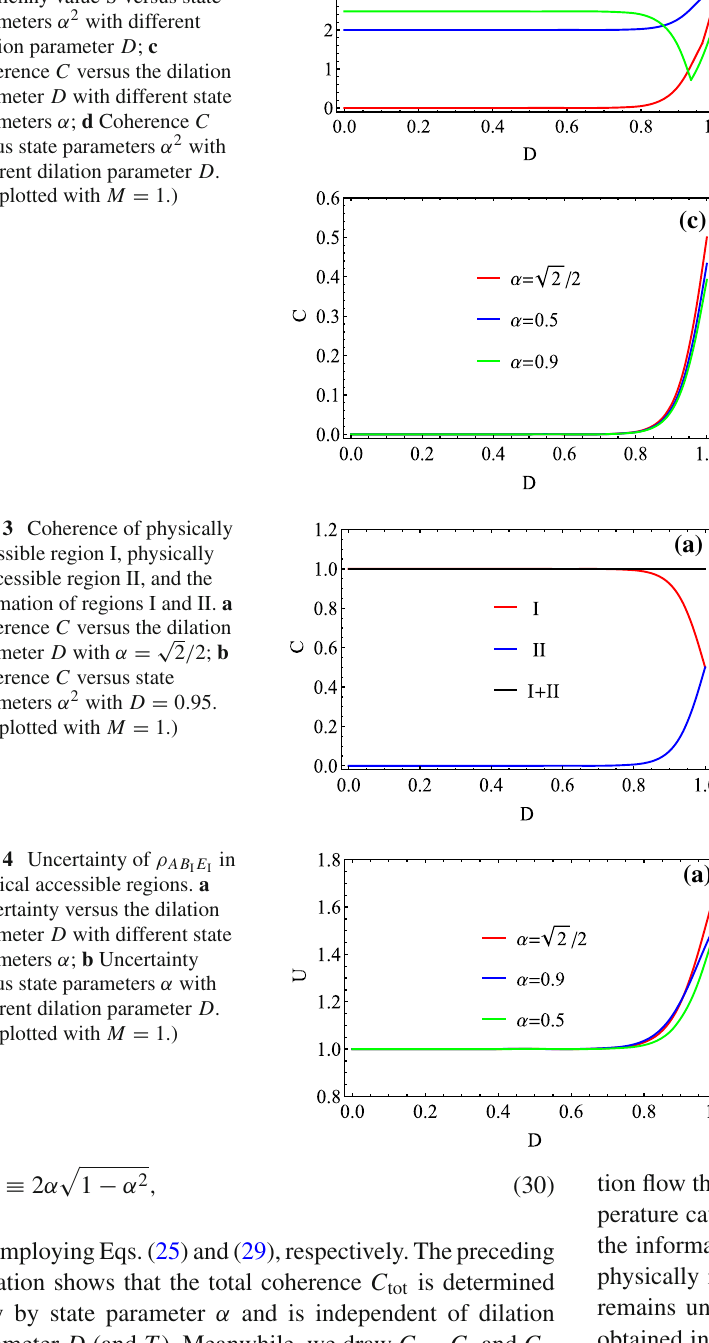
Fig. 2 Nonlocality and coherence for ρ AB . a II E II Svetlichny value S versus the dilation parameter D with different state parameters α ; b Svetlichny value S versus state parameters α 2 with different dilation parameter D ; c Coherence C versus the dilation parameter D with different state parameters α ; d Coherence C versus state parameters α 2 with different dilation parameter D . (All plotted with M = 1.)